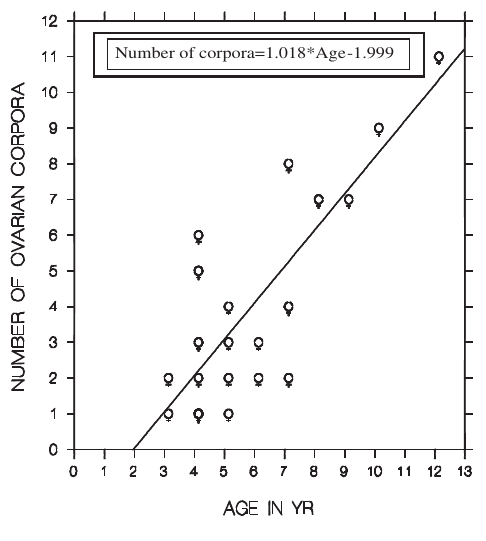
Fig.13. Total corpora num- ber at age for female por- poise, all